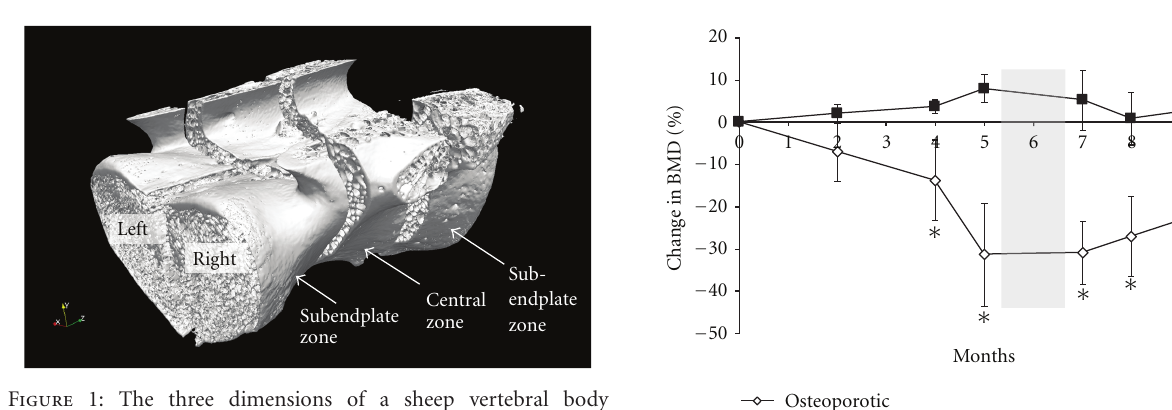
Figure 1: The three dimensions of a sheep vertebral body demonstrating the regions of interest examined (two subendplate zones, central zone, left and right sides).